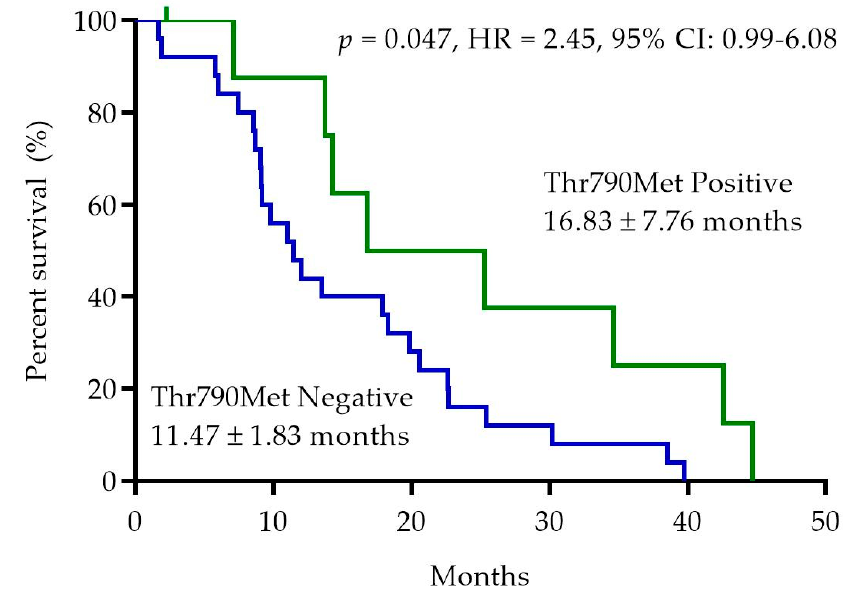
Figure 3. Duration of progression-free survival according to consensus EGFR -Thr790Met pretreatment status determined by PNA Clamp TaqMan Assay and ddPCR. HR: Hazard ratio, CI: Confidence interval.